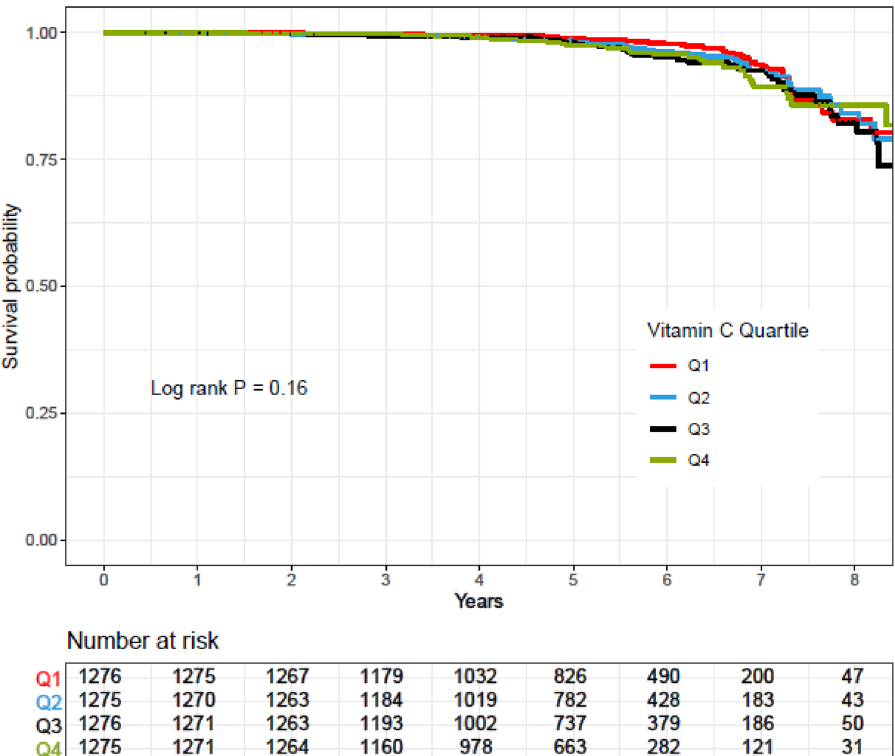
Figure 3. Kaplan–Meier estimates of CVD-free survival according to quartiles of vitamin C intake. P values by log-rank test and number of CVD outcomes recorded in the groups categorized by vitamin C intake.